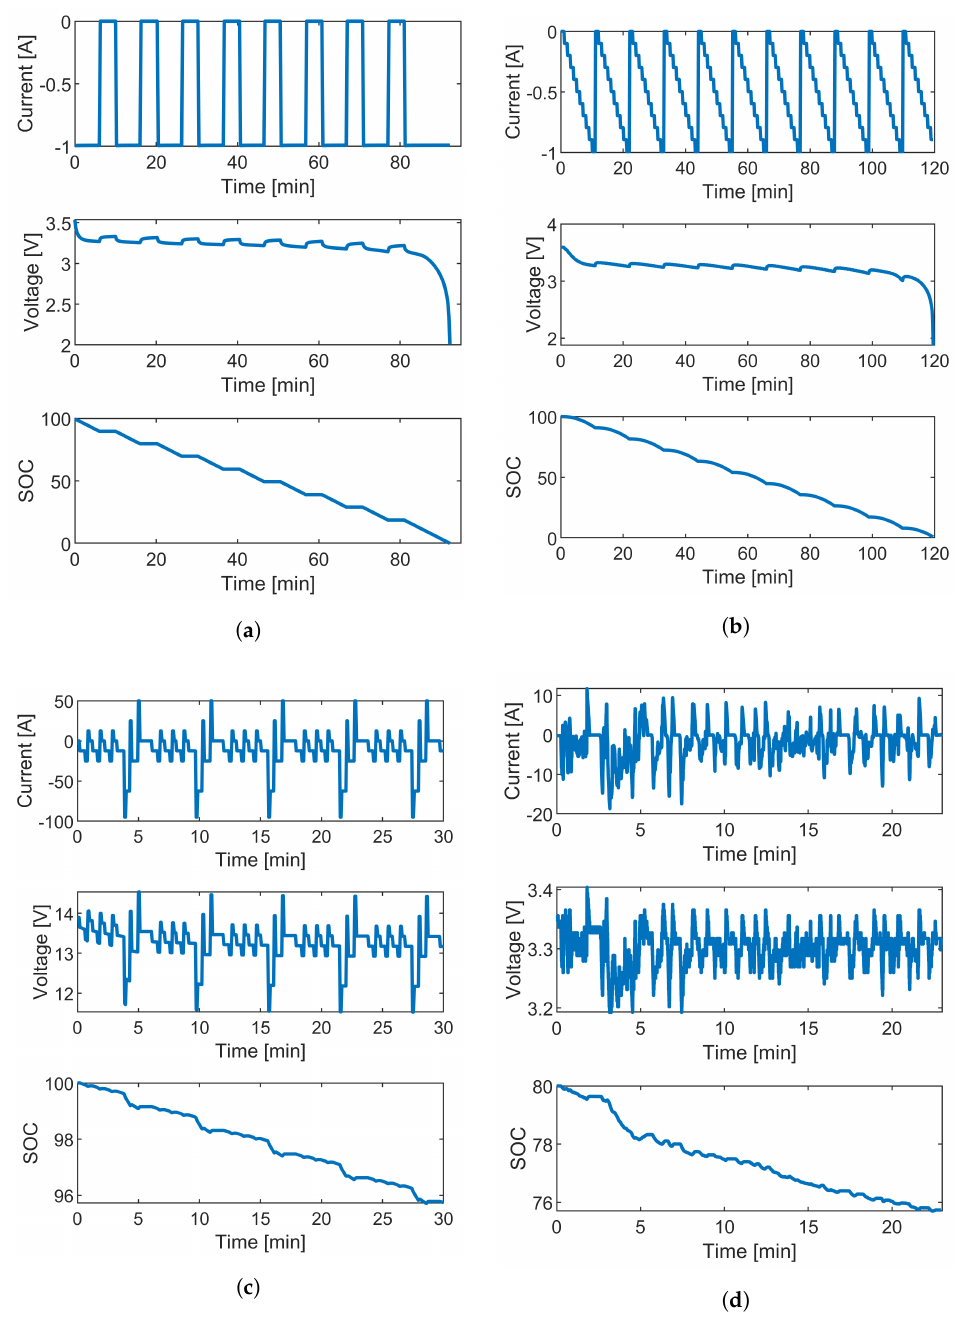
Figure 4. Test profiles showing current, voltage, and SOC sequences for the battery cell from a fully charged state to fully drained ( a ) Constant Pulse Discharge Test. ( b ) Variable Pulse Discharge Test. ( c ) DST test (cycles 1 through 5). ( d ) UDDS